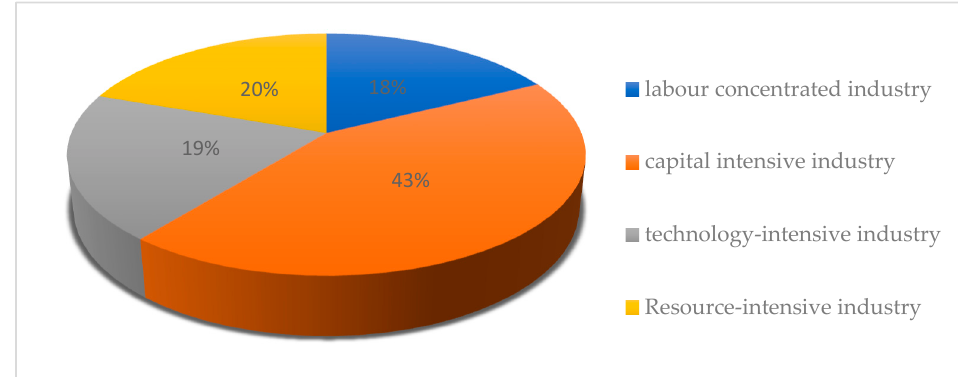
Figure 4. Proportion of four industrial categories in Nanjing’s 51 industrial heritage sites (Figure source: own drawing).